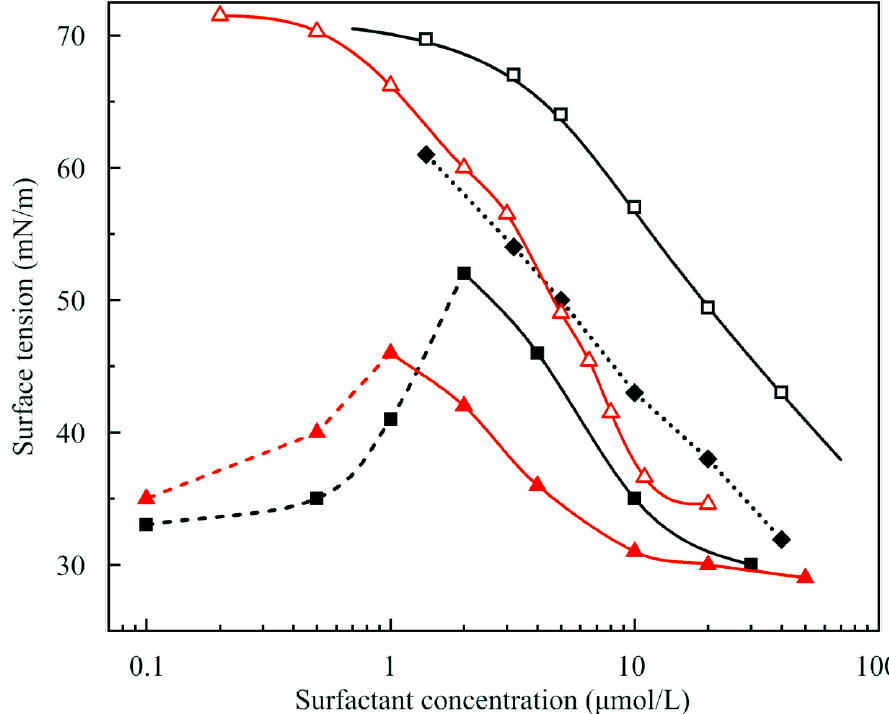
Figure 14. Equilibrium surface tension values for the drops of C 13 DMPO and C 14 EO 8 solutions at the interface with air (open symbols) and saturated hexane vapor (filled symbols). For details see text.